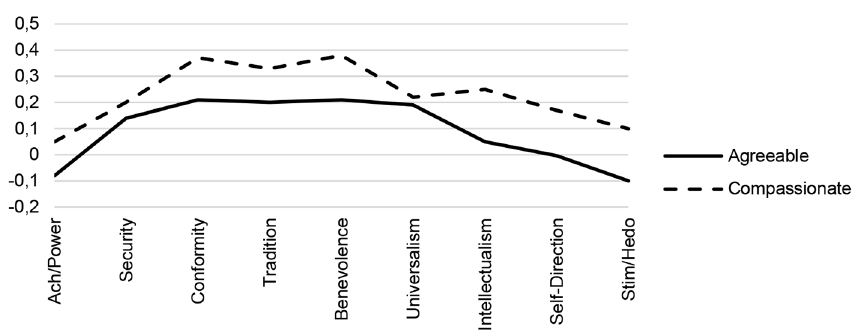
Figure 2. Results for social tendency traits (agreeable and compassionate).